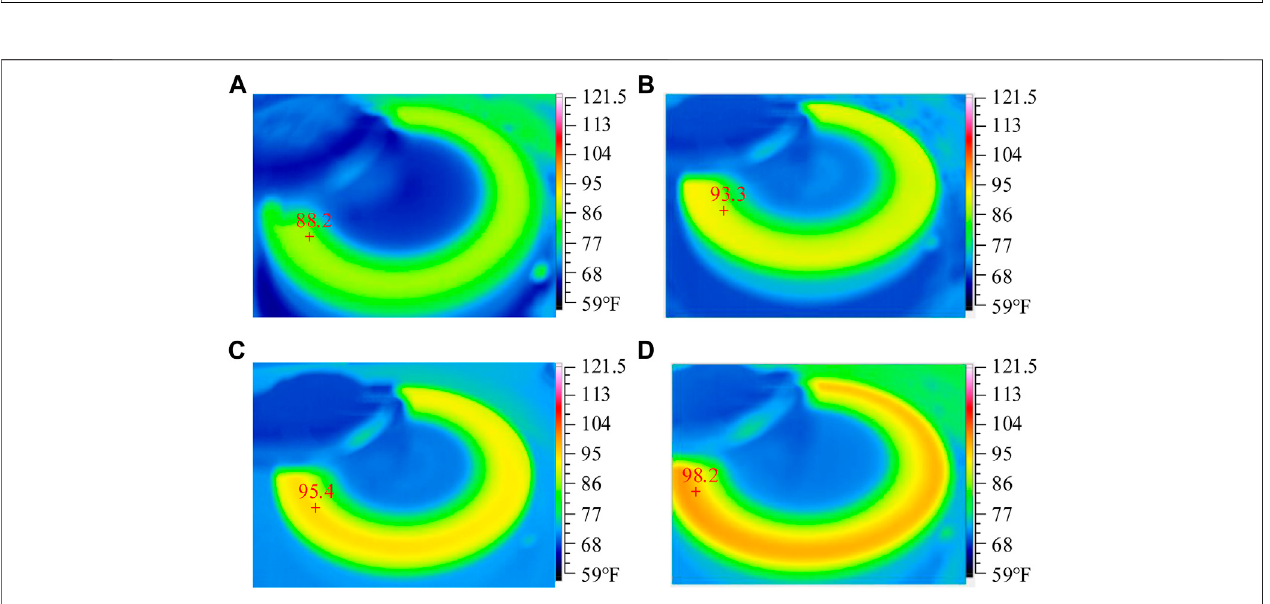
Figure 5 that after the processing time of 20 s, the distribution of the temperature fi eld on the lapping-polishing plate seems to be stable, and with the increase of pressure, the average temperature while along the radial direction of the lapping-polishing plate the